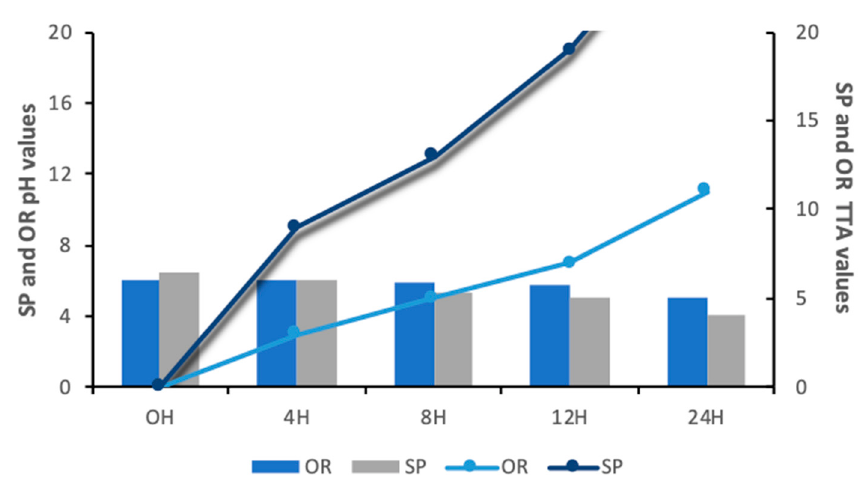
Figure 2. The evolution of pH and total titrable acidity (TTA) of both spontaneously fermented sourdough (OR) and of sourdough fermented with Lactobacillus spicheri DSMZ 15429 (SP) during 24 h of fermentation.